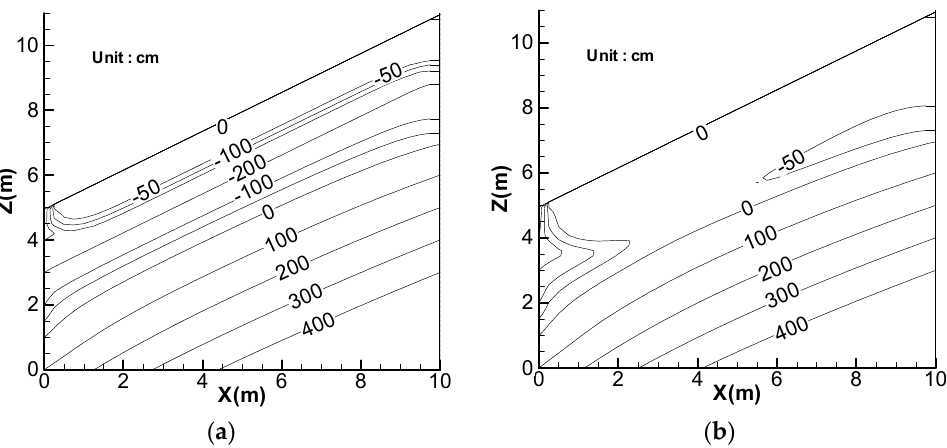
Figure 9. Pressure head contours for duration of 12 h with uniform rainfall of 400 mm at time: ( a ) 6 h; and ( b ) 12 h.